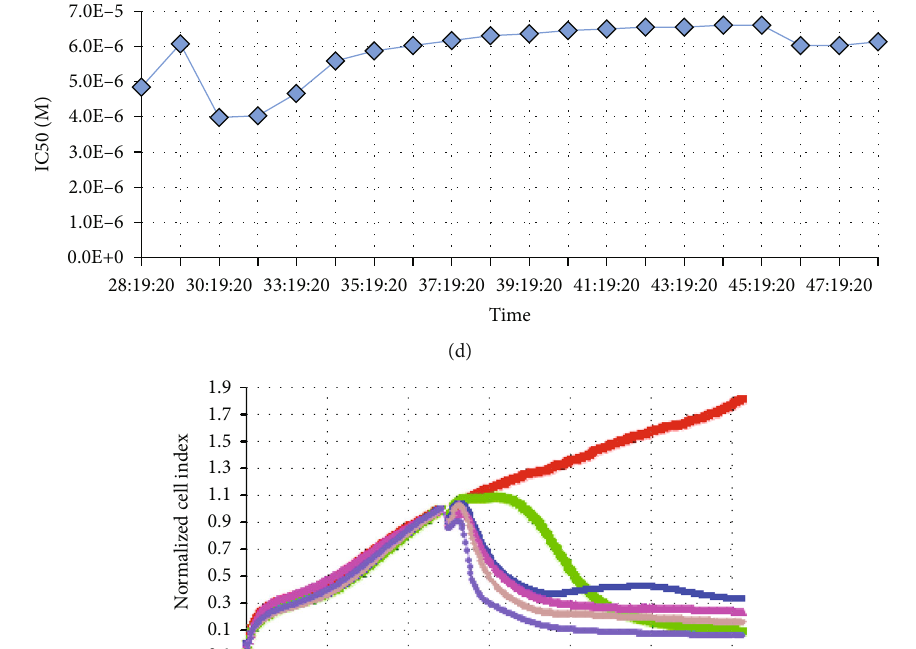
Figure 3: Cell viability of 3F1 determined by real-time cell analysis. (a, c, e) Normalized cell index. (b, d, f) Real-time-dependent IC compound 3F1 against MDA-MB-231, MCF-7, and H9c2 cells. MDA-MB-231, MCF-7, and H9c2 cells were treated with DMSO for negative control, treated with CDDP (positive control), or the indicated concentrations of compound 3F1 for 24h in E-plates. Data are presented as the mean ± S : D : of two independent experiments performed in